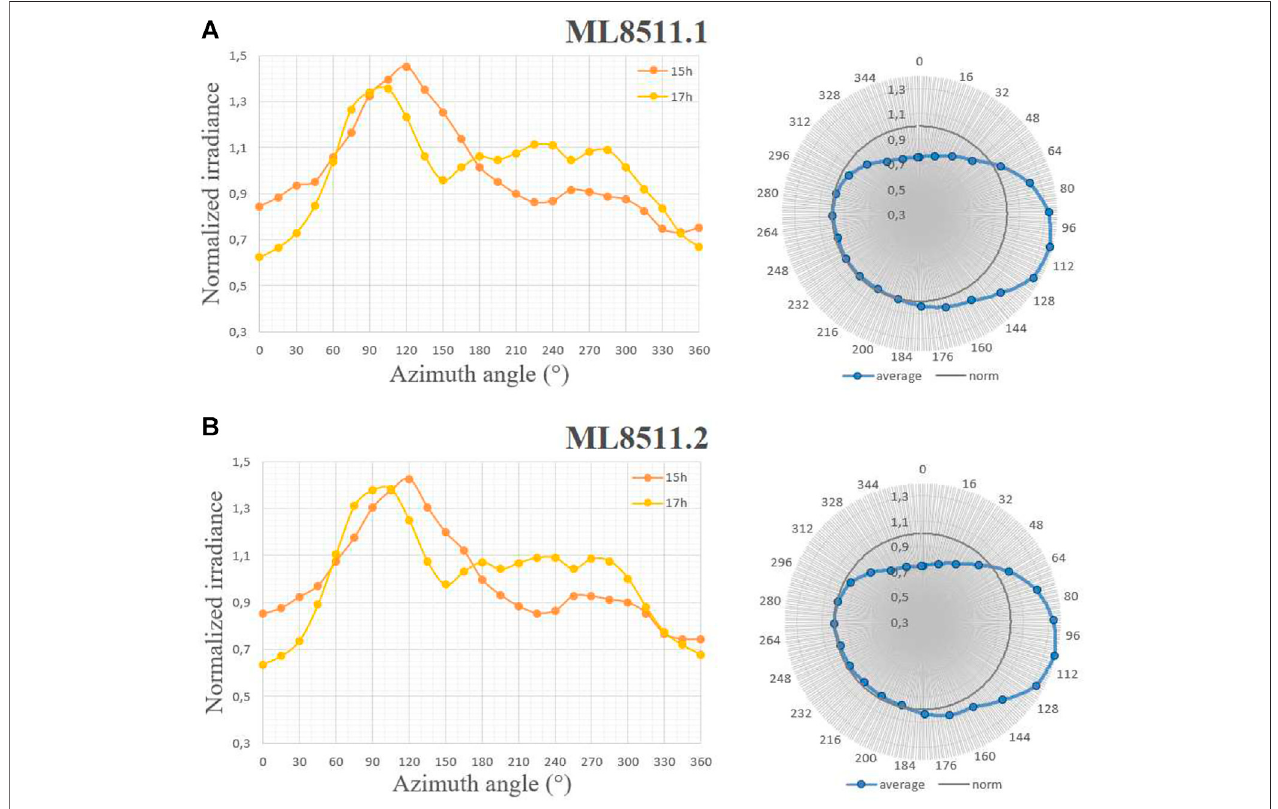
FIGURE 11 | Azimuth response of sensors ML8511.1 (A) and ML8511.2 (B) : Output signal for different azimuth angles at different hours (left) and mean azimuth response